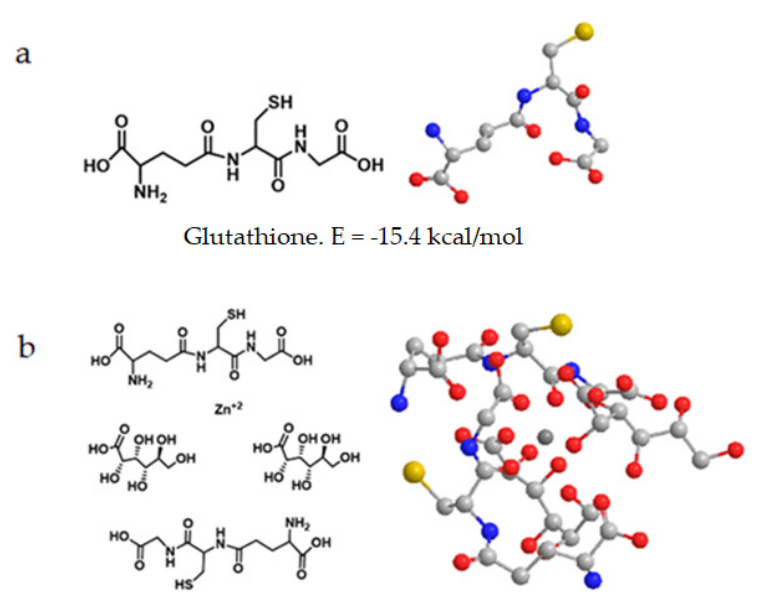
Figure 9. Energy content and most favorable spatial orientation of free glutathione ( a ) and when complexed with zinc gluconate ( b ). Light grey balls represent carbon atoms. Blue balls represent nitrogen atoms. Non linked dark grey balls represent zinc cations. Red balls represent oxygen atoms and yellow balls represent sulfur atoms.